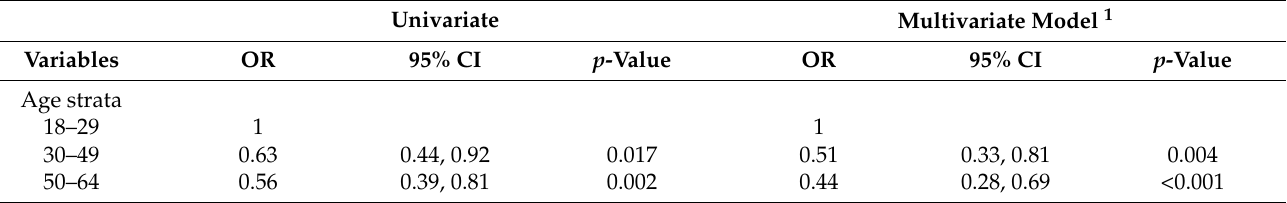
Table 5. Predictors associated with discharge directly to a rehabilitation unit. Subgroup analysis of patients admitted with moderate–severe TBI ( n = 873): 862 patients were included in the model; 11 were excluded (7 patients’ GOS 5-GR, 4 patients’ GOS not